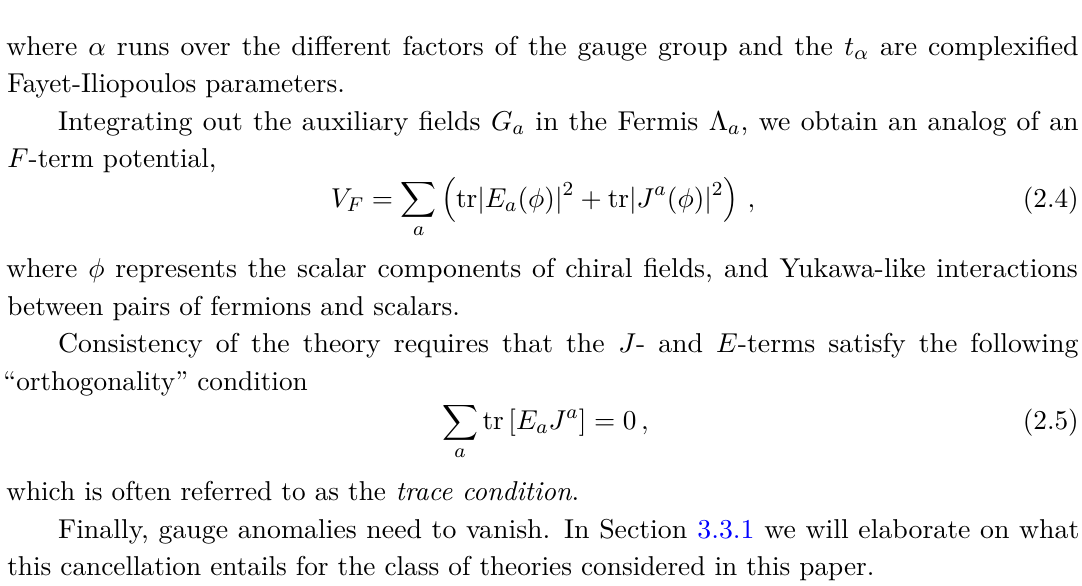
Figure 1 . A BFT 2 defined on a 3-ball with S 2 boundary. We refer to this simple theory as the cube model